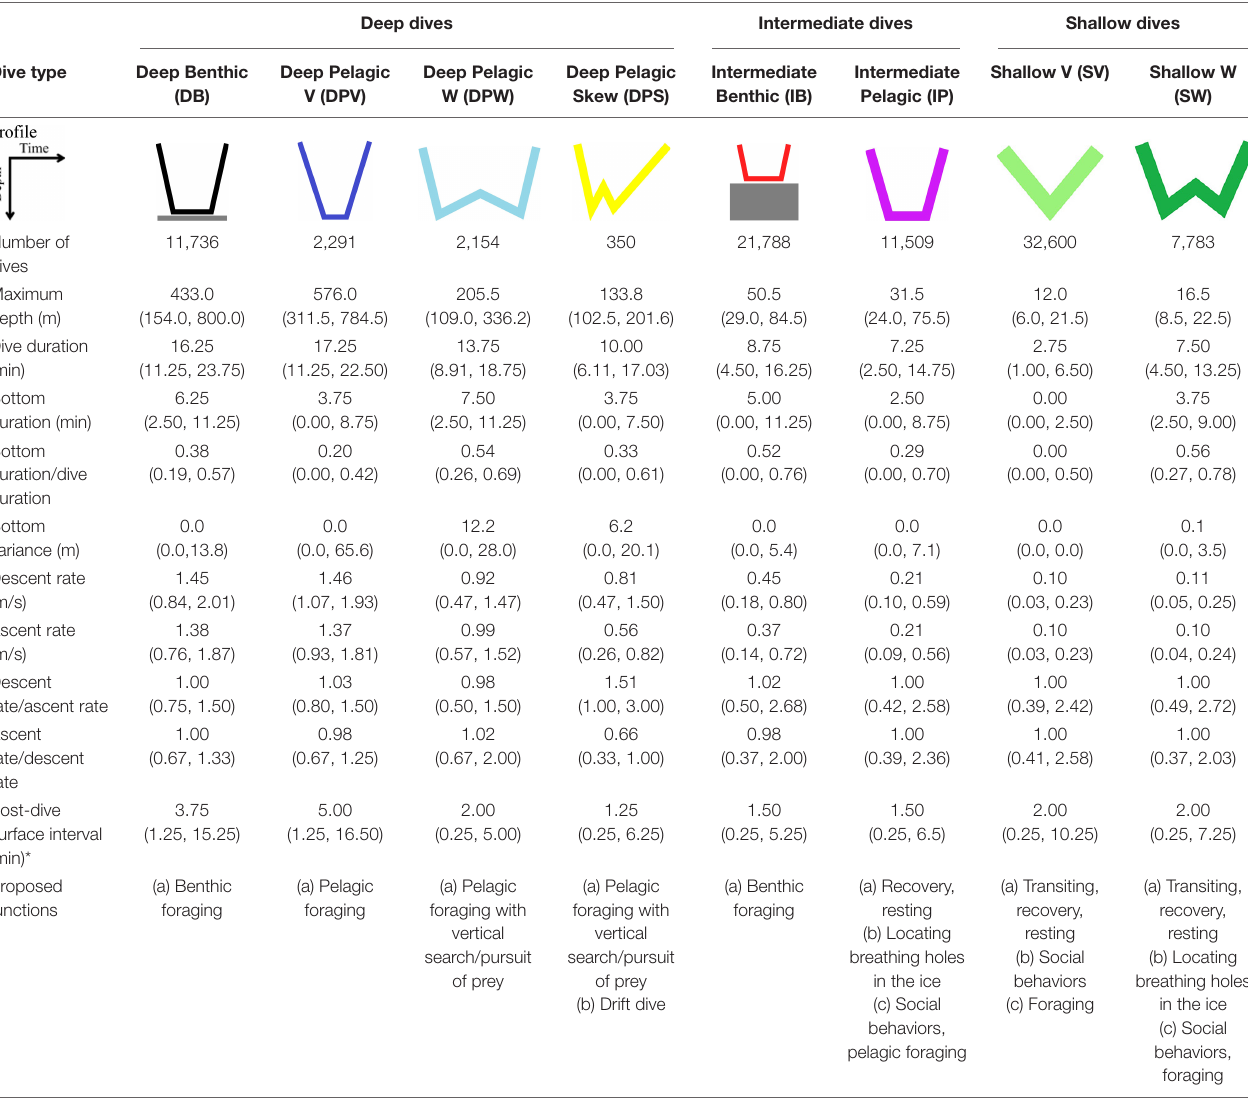
TABLE 2 | Characteristics of the eight dive types identified using Gaussian mixed models, PCA, and hierarchical clustering analyses for male EBS